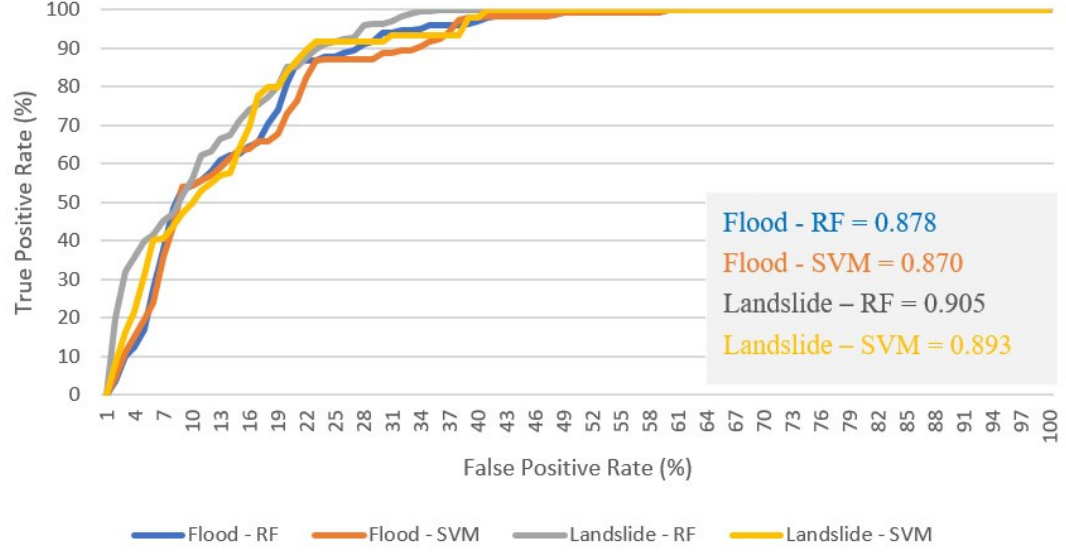
Figure 8. Accuracy of each model with AUC values for flood and landslide using RF and SVM.